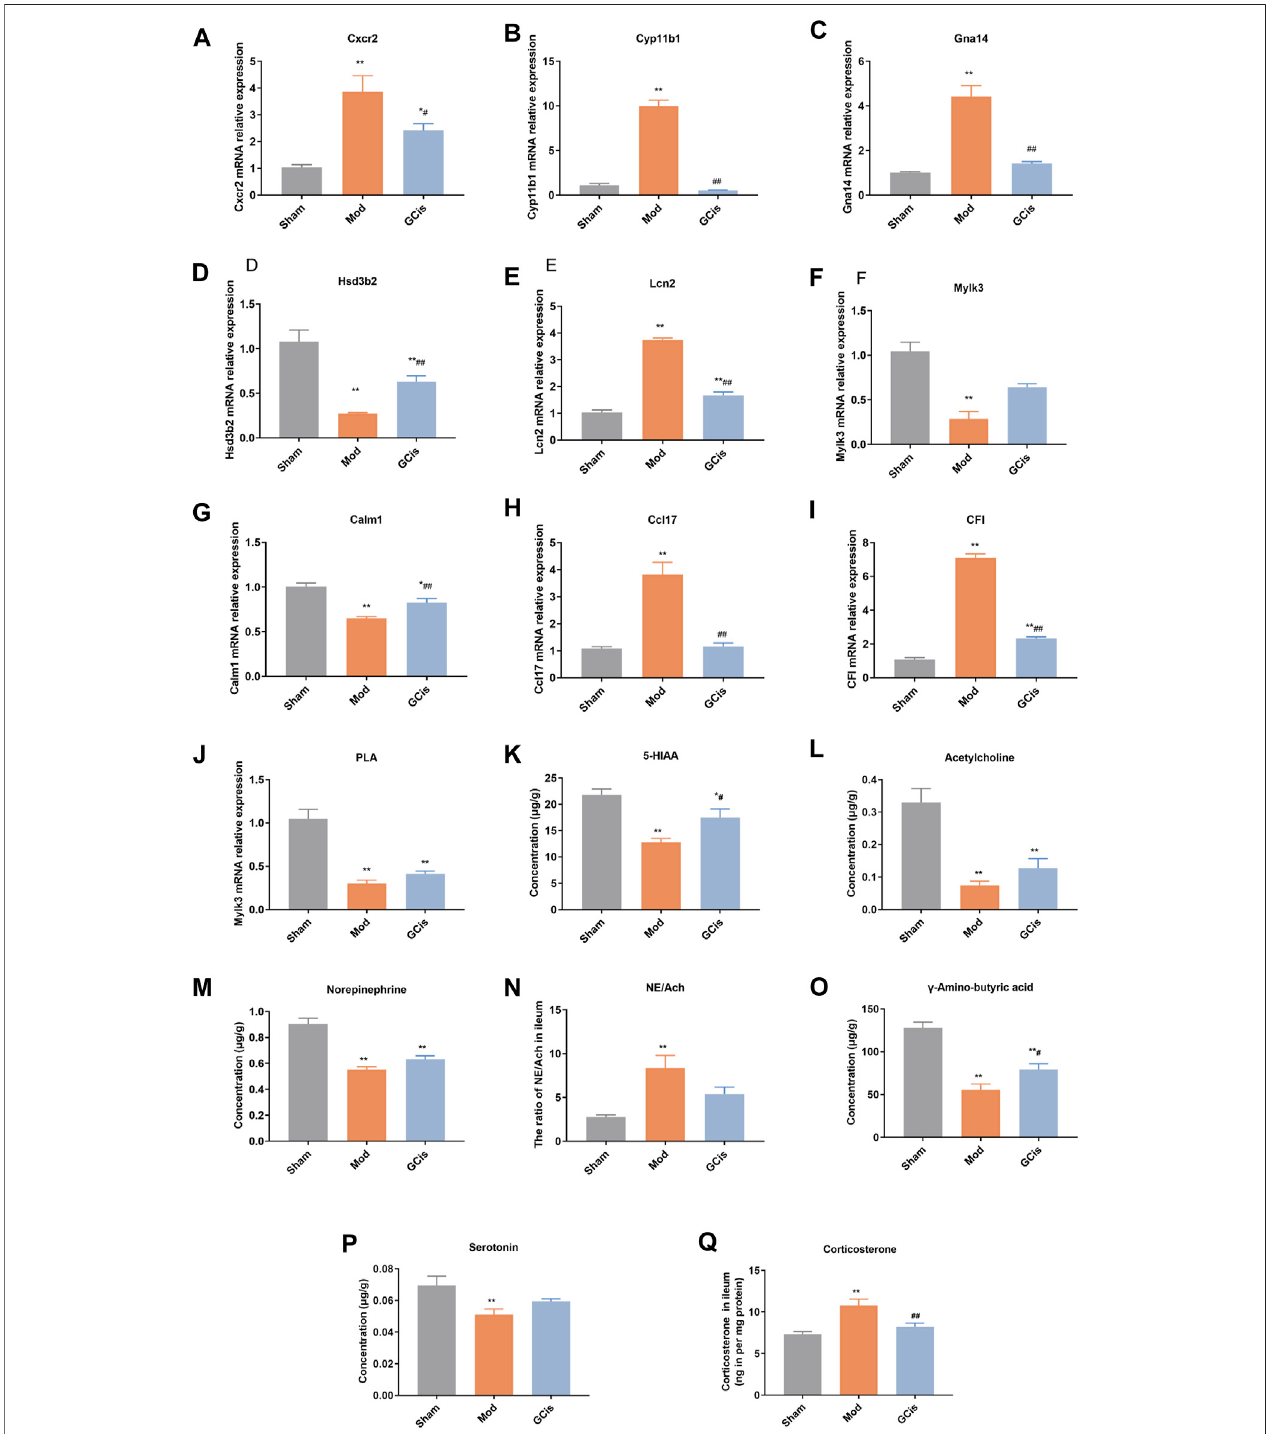
FIGURE7| ValidationofCxcr2 (A) ,Cyp11b1 (B) ,Gna14 (C) ,Hsd3b2 (D) ,Lcn2 (E) ,Mylk3 (F) ,Calm1 (G) ,Ccl17 (H) ,CFI (I) ,PLA (J) ,5-HIAA (K) ,acetylcholine (L) , norepinephrine (M) , NE/Ach (N) , γ -amino-butyric acid (O) , serotonin (P) , and corticosterone (Q) (data are shown as mean ± SEM. ** p < 0.01 compared with the sham group; # p < 0.05 and ## p < 0.01 and compared with the model group).